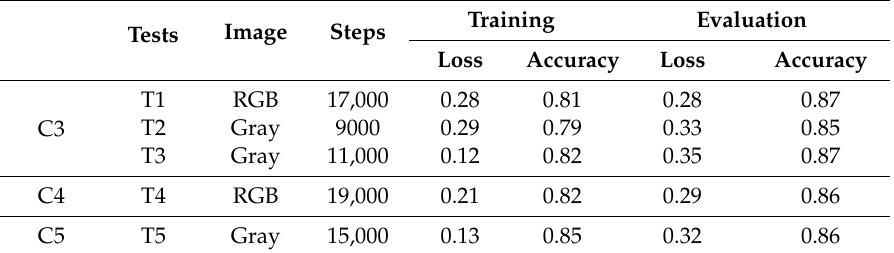
Table 4. Results obtained with the networks based on ZF Net—Using half of the database.